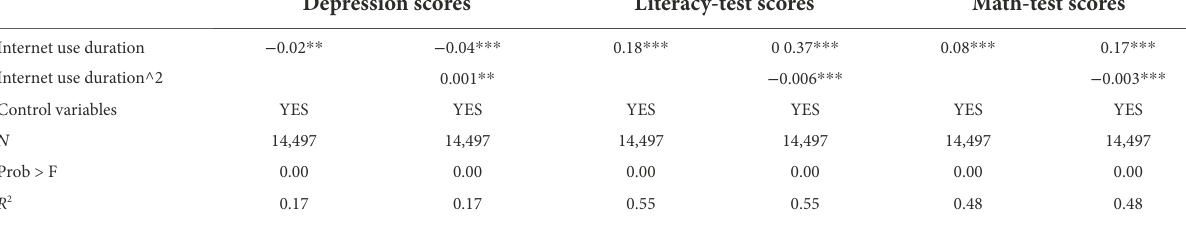
TABLE 4 Relationship between Internet use duration and mental